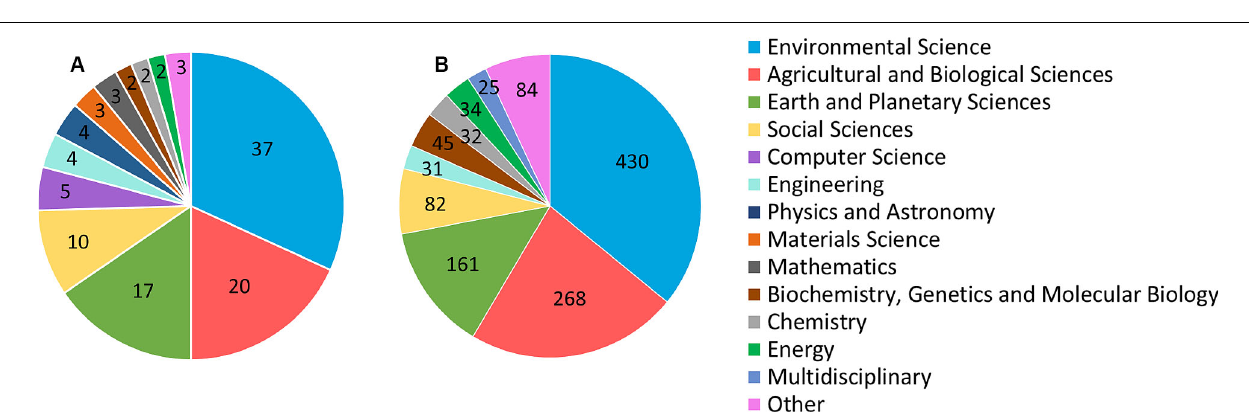
FIGURE 5 | The proportion of different subject areas (size of pie slices) and related number of Scopus documents associated with the journals in which (A) the 66 Scopus-indexed SMART EMJD papers have been published and (B) all 709 papers citing the SMART EMJD papers have been published. TABLE 1 | Initial backgrounds of the SMART EMJD doctoral candidates and supervisors per institute. GEO- ECO- GEO- ECO- ECO- BIO- ECO HYDRO GEO MATICS HYDRO HYDRO GEO HYDRO-GEO